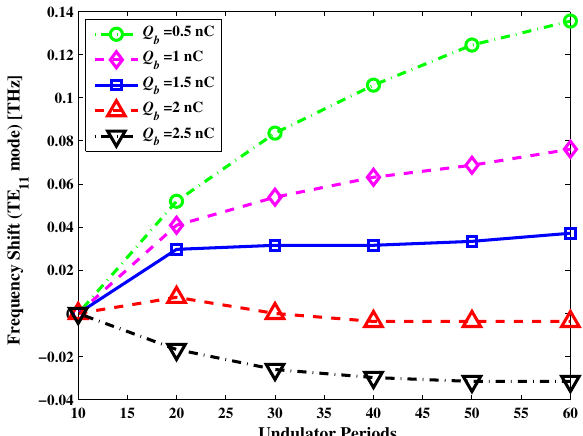
FIG. 8. Frequency shift of the radiation during the motion of the